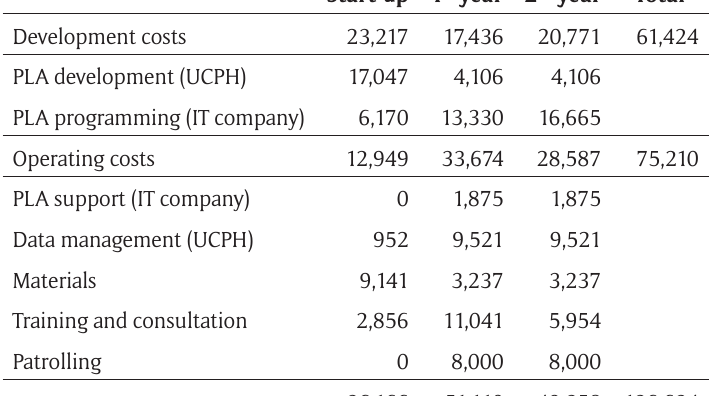
Table 4: Costs of the community-based monitoring program with use of ICT in Prey Lang, Cambodia. Shown are actual costs incurred during the start-up phase (August 2014–January 2015) and in each of the two years of monitoring (February 2015–February 2017, in $US, as of September 2017). PLA, Prey Lang App. UCPH, University of